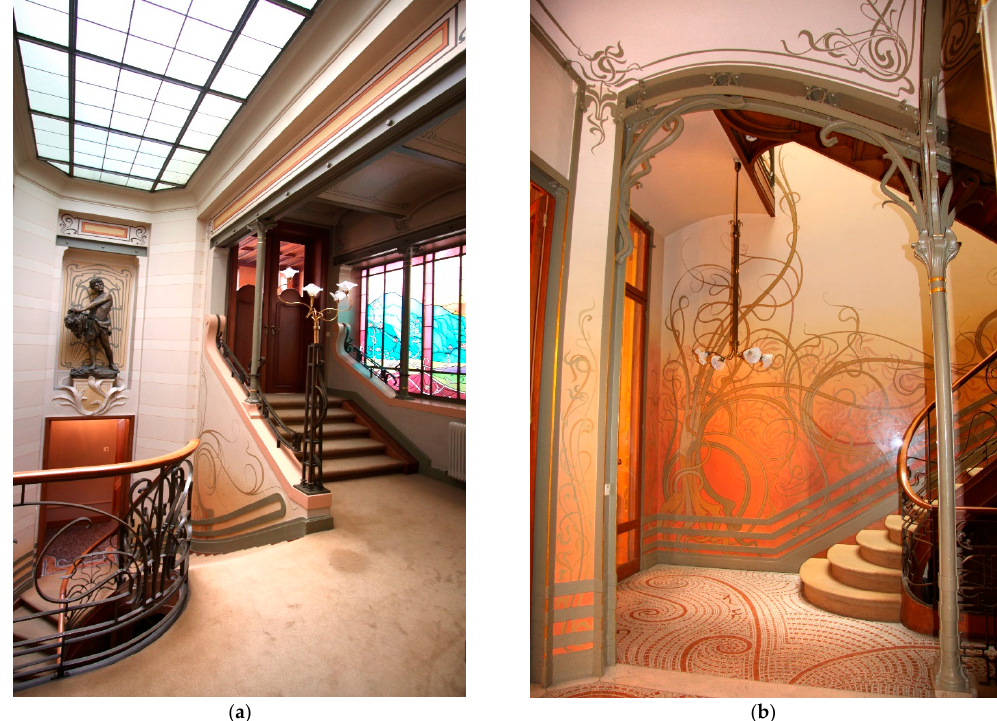
Figure 5. In the Tassel House, a large amount of daylight and biomorphic forms of structures and decorations clearly indicate the inspirations drawn from nature: ( a ) The skylight above the staircase; ( b ) the biological decoration and structure of the staircase.